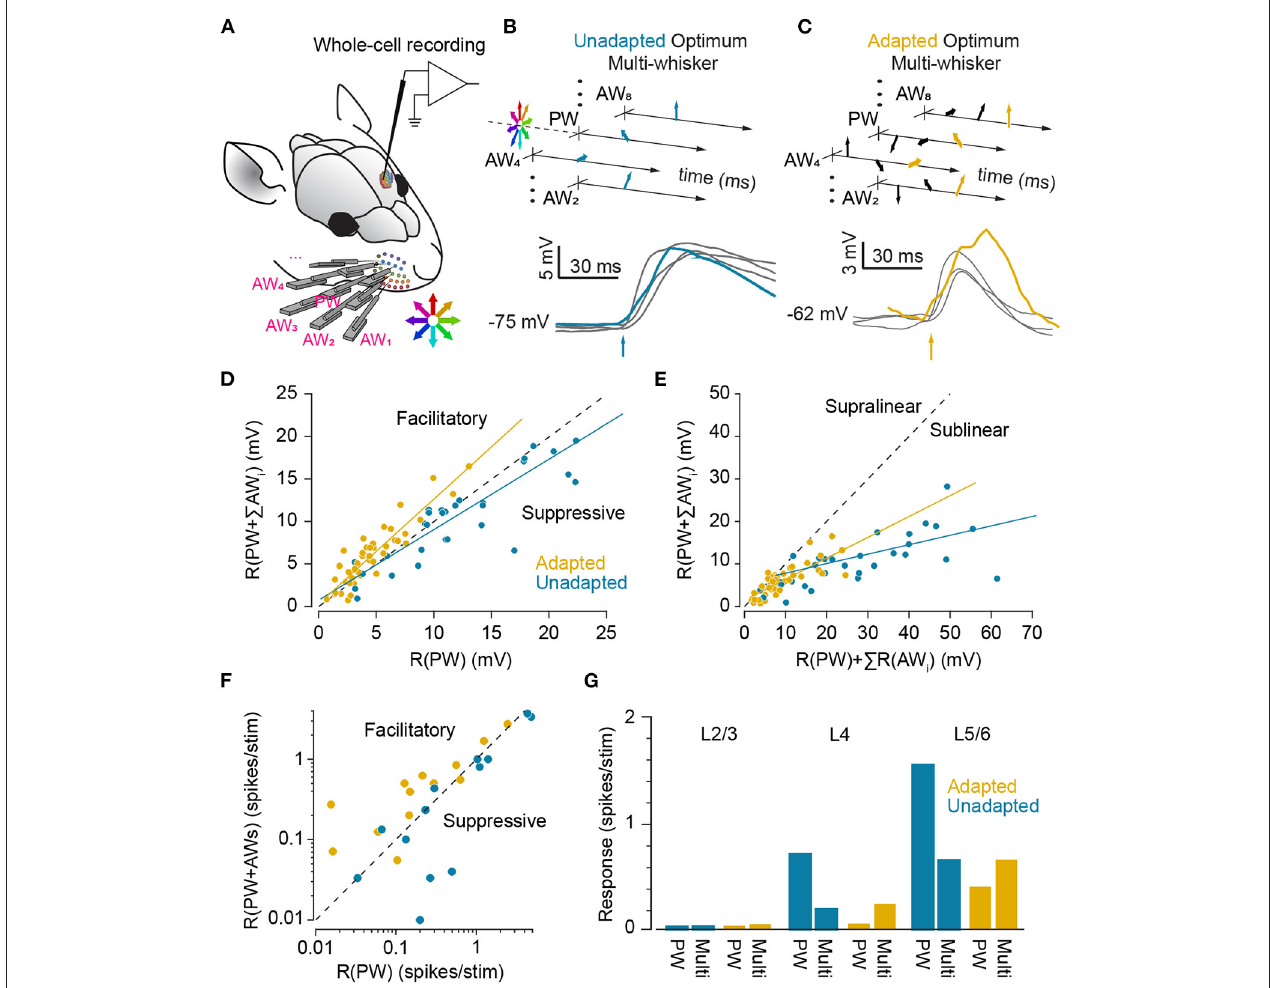
FIGURE 8 | Adaptation enhances summation of synaptic inputs and allows surround stimuli to facilitate responses. (A) Cortical neurons in the vibrissal area of S1 were recorded intra-cellularly during complex multi-whisker stimulation to nine whiskers. The principal whisker (PW) and each of the eight adjacent whiskers (AW) were stimulated with high-velocity deflections of fixed temporal structure (5-ms rise and 5-ms decay) in arbitrary angles. Deflections occurred stochastically in time and direction at a frequency of ∼ 9.1 Hz. The inset represents whisker directions in an eight angle-binned space. (B) The multi-whisker stimulus that evokes the maximum response for each neuron was determined and played back in isolation (unadapted). Trial-averaged post-synaptic responses of a neuron to each of the nine whiskers, R(PW) or R(AW) are shown in black. The arrow indicates stimulus onset. The response to the multi-whisker stimuli, R(PW + 6 AW i ), is shown in cyan